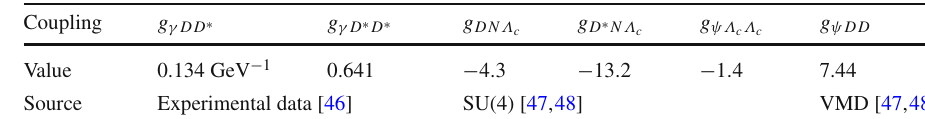
Table 1 Values of the couplings in the Lagrangians in